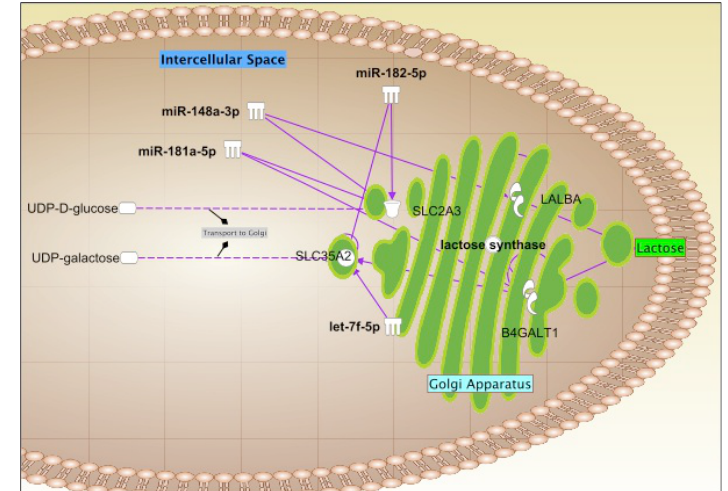
Figure 6. HM lactose synthesis in the mammary gland during lactation is regulated by 4 highly expressed miRNAs in HM (shown in white color). Importantly, miR-182-5p and let-7f-5p regulate SLC2A3 (UDP-glucose transporter) and SL35A2 (UDP-galactose transporter).